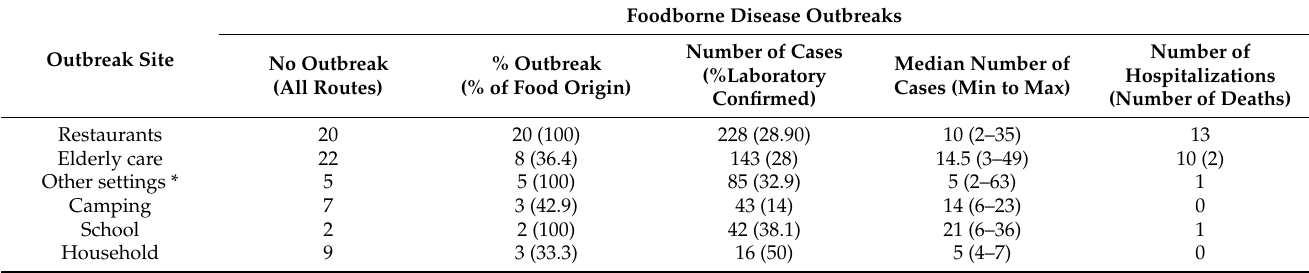
Table 2. Characteristics of Campylobacter outbreaks by location in Australia, between 2001 and